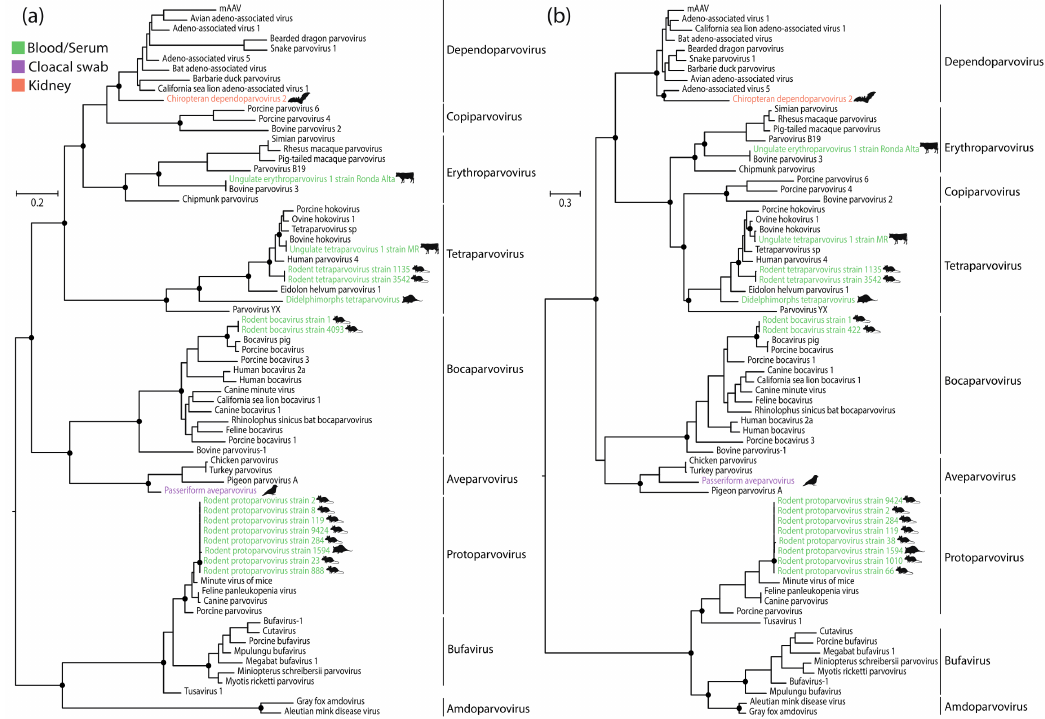
Figure 2. Maximum likelihood (ML) phylogenies showing the evolutionary relationships of newly identified parvoviruses. ( a ) Phylogenetic tree of non-structural (NS) proteins; ( b ) Phylogenetic tree of viral proteins (VPs). Phylogenies are midpoint rooted for clarity of presentation. The scale bar indicates evolutionary distance in substitutions per amino acid site. Black lines indicate genera within the Parvovirinae subfamily. Black circles indicate nodes with maximum likelihood bootstrap support levels >75%, based on 1000 bootstrap replicates. Taxa names of parvoviruses identified in our study are coloured according to sample type, as shown in the key. Silhouettes indicate host species